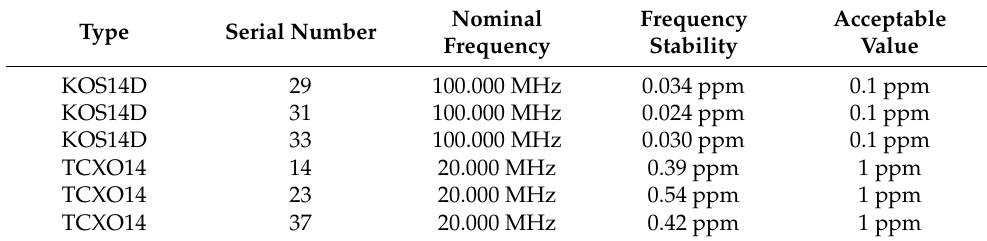
Table 1. Test data of the crystal oscillator frequency stability at 40 ◦